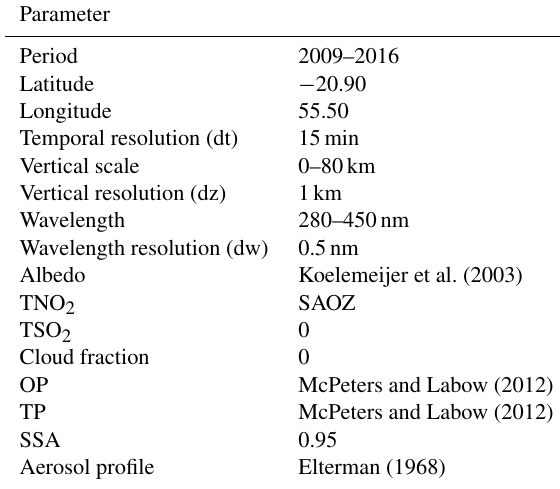
Table 2. Baseline configuration of the TUV